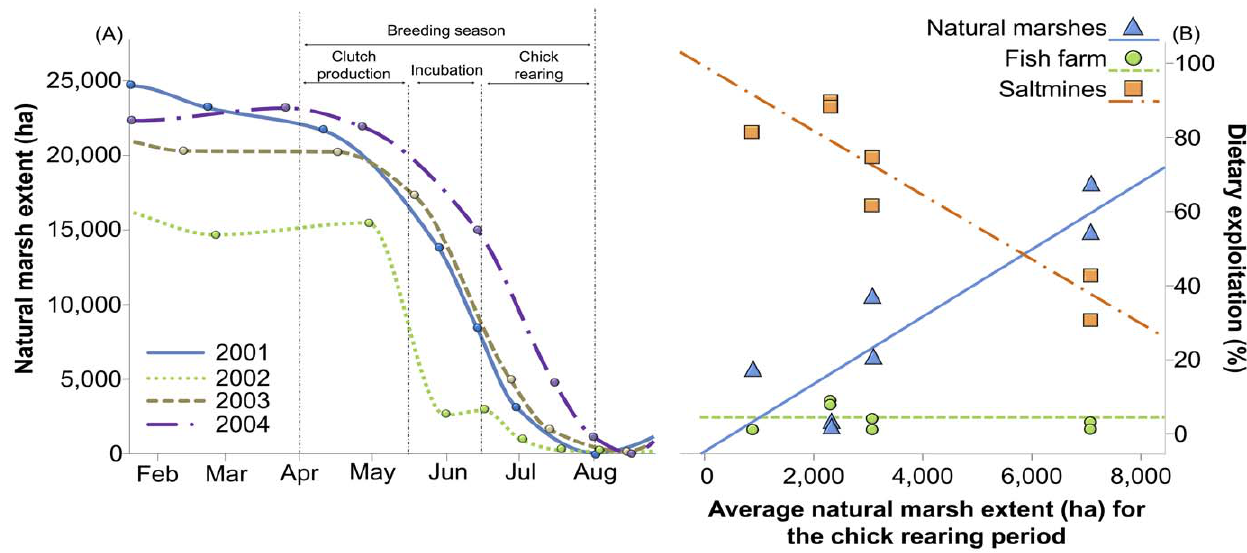
Figure 3. Linking natural resource availability with fledglings’ diet. (A) Temporal trends for the flooded areas (ha) at the natural marshes for the 2001–2004 period. Dots represent real flooded areas obtained from satellite images. (B) Relationship between the estimated flooded area at the natural marshes (ha) during the chick-rearing period and the estimated relative contribution of natural resources (blue), and resources from the fish farm (green) and the saltmines (orange) to the diet of Slender-billed Gull fledglings. Dots represent dietary estimates for fledglings hatched at